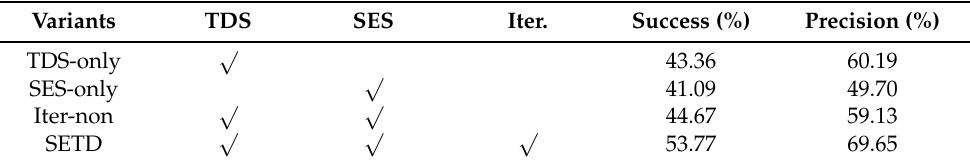
Table 4. Self-contrast experiments evaluated by the success and precision ratio. SETD achieved the best